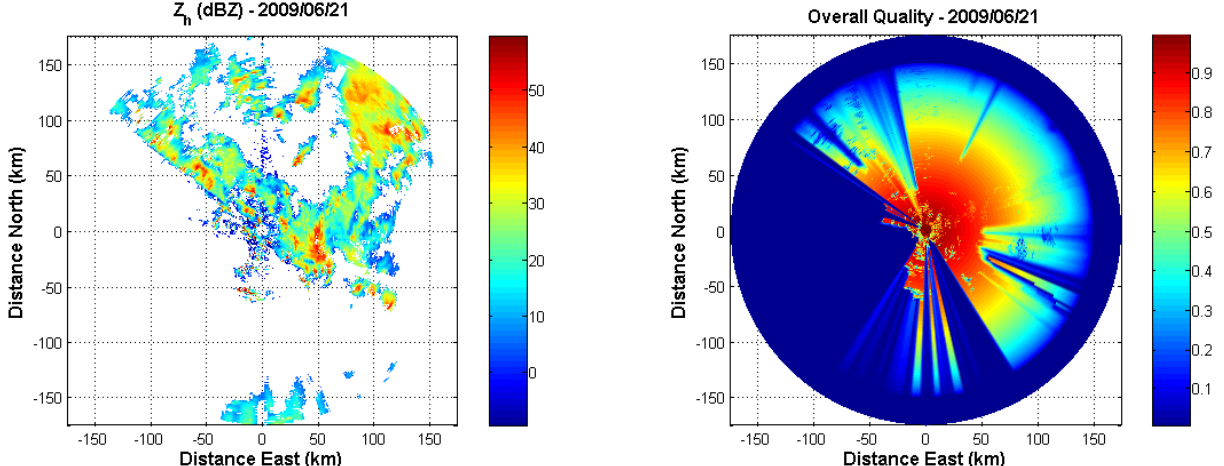
Fig. 7. Reflectivity measured by radar “Il Monte”, on 21 June 2009, at 14:00UTC, elevation 0.4 (left), and overall quality map associated Fig. 7: Reflectivity measured by radar “Il Monte”, on June 21, 2009, at 14.00 UTC, elevation 0.4 1400 with it (right). The dominant component in quality is the range (left), and overall quality map associated to it (right). The dominant component in quality is the 1401 range distance. 1402